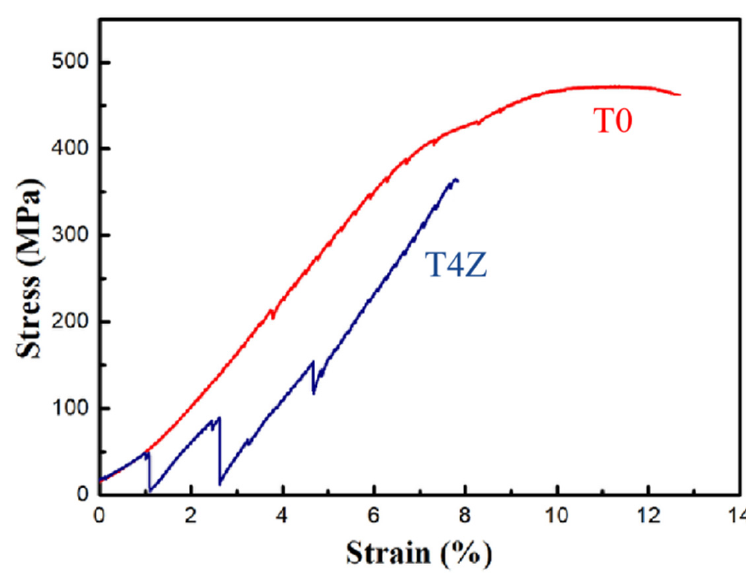
Figure 13. Stress–strain curves of T0 and T4Z alloys for tensile testing at 600 °C.